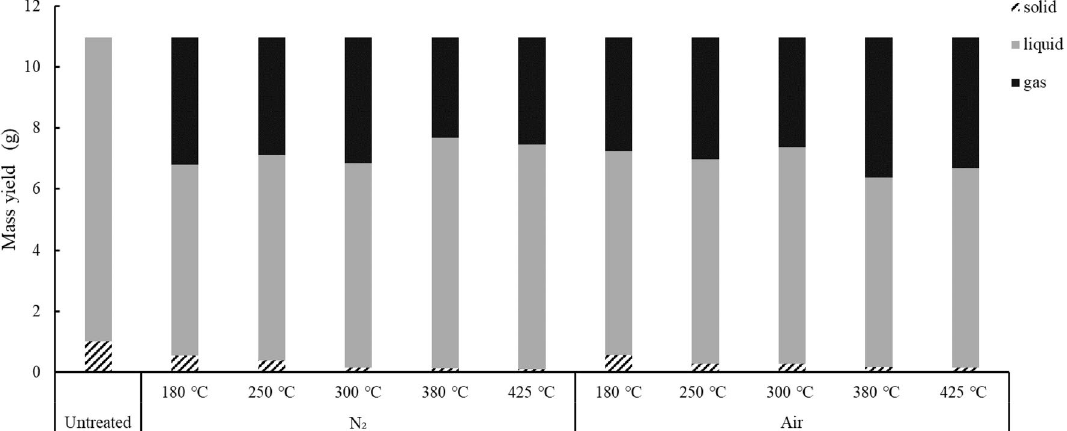
Fig. 4 Results of mass balance calculations for each group of